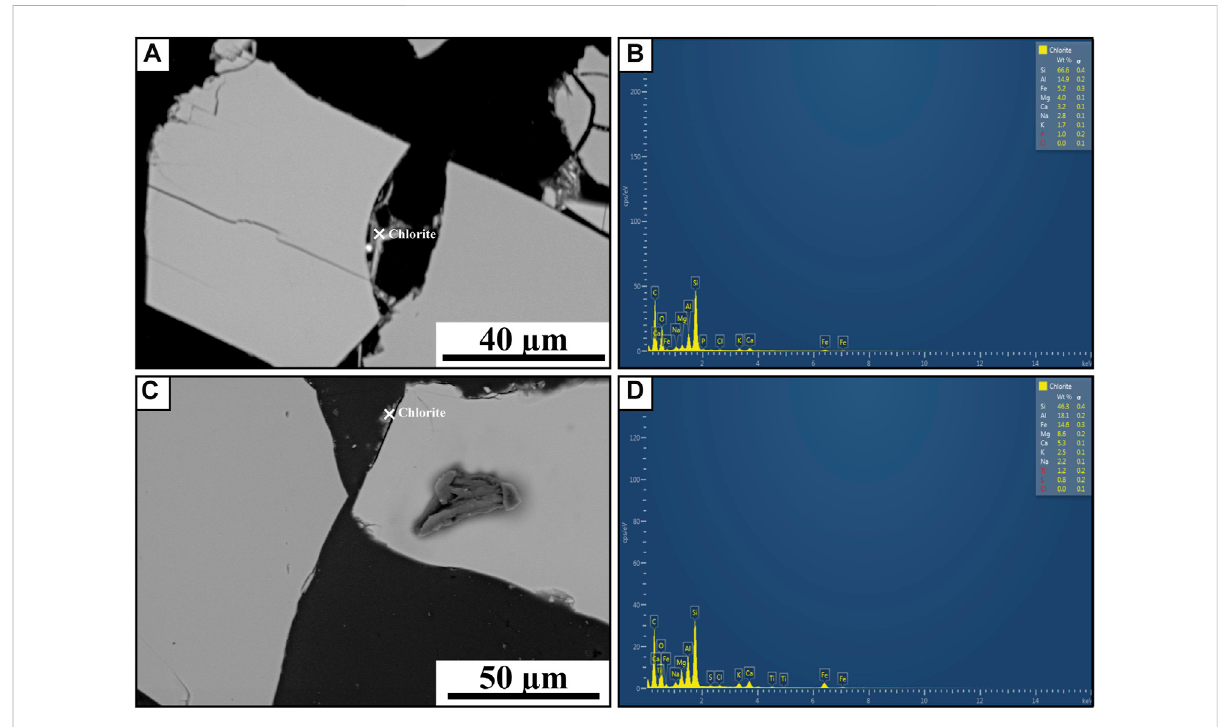
FIGURE 10 SEM images and EDS spectra for precursor, mg-rich chlorite coats. (A) SEM image showing precursor chlorite coating detrital grain (Sample 1). (B) EDS spectra for the Mg-rich chlorite coat in (A) . (C) SEM image showing precursor, Mg-rich chlorite coating detrital grain (Sample 4). (D) EDS spectra for the Mg-rich chlorite coat in (C)